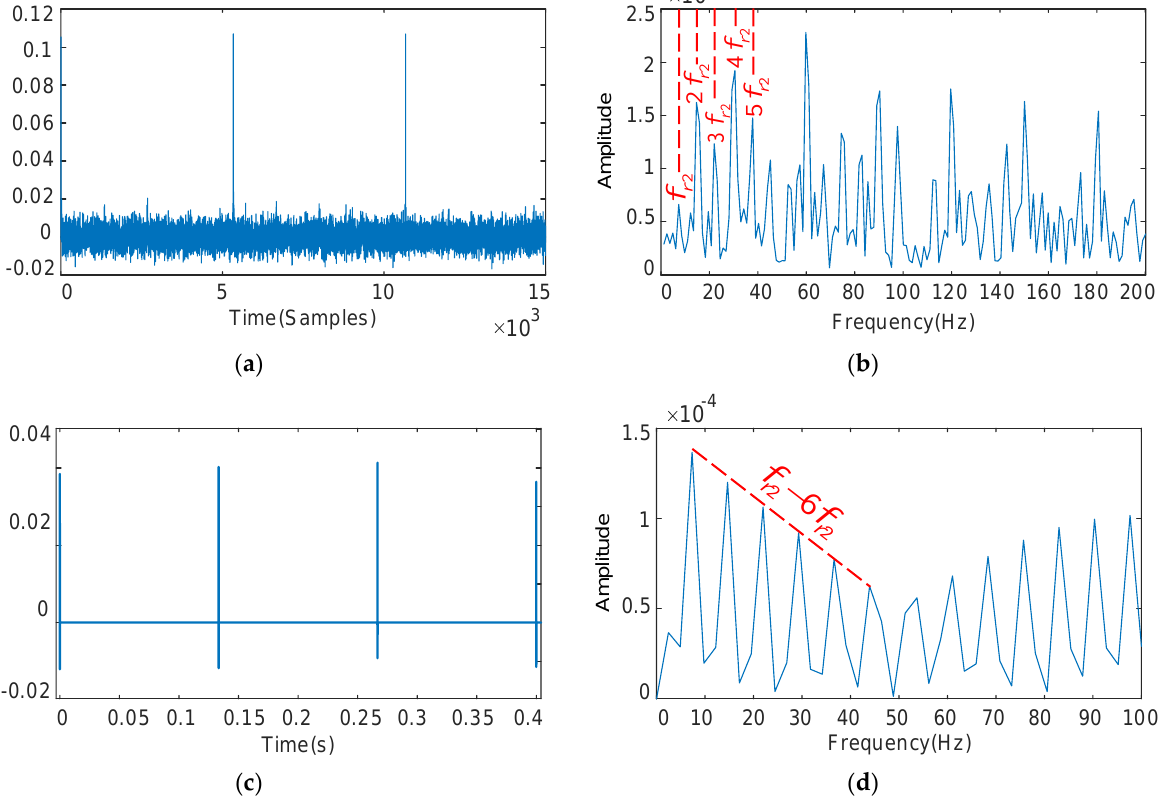
Figure 8. The decoupled gear vibration signal and its frequency spectrum: deconvolution results of MOMEDA: filtered time domain waveforms and their frequency spectrum ( a , b ); Results obtained by MOMEDA and optimized RSSD: time domain waveforms and their frequency spectrum ( c , d ).